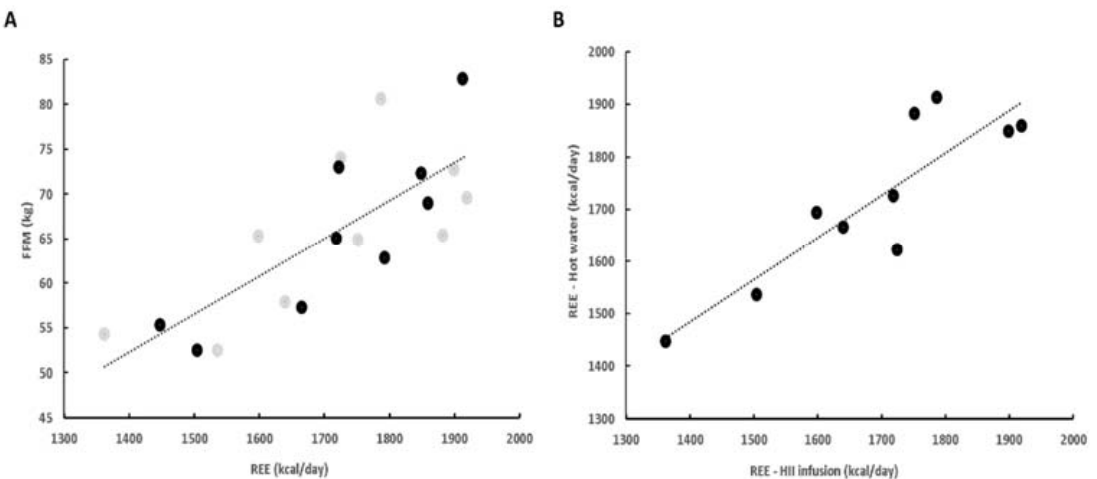
Figure 3. ( A ) Positive correlation between FFM and REE (R = 0.78; gray—HII infusion, black—hot water). ( B ) Positive correlation between initial REE before ingestion of HII infusion and hot water (R = 0.88). FFM—fat free mass; HII— Helichrysum italicum ssp. italicum ; REE—resting energy expenditure. 2.3. Acute Effects of a Single Ingestion of HII Infusion on Energy Expenditure and Blood Pressure